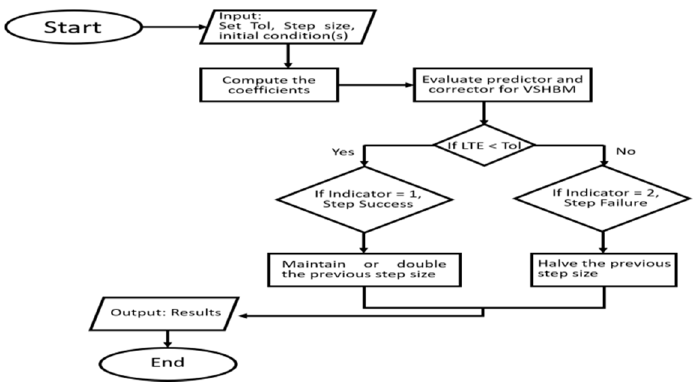
Figure 3. Flowchart for the proposed VSHBM.